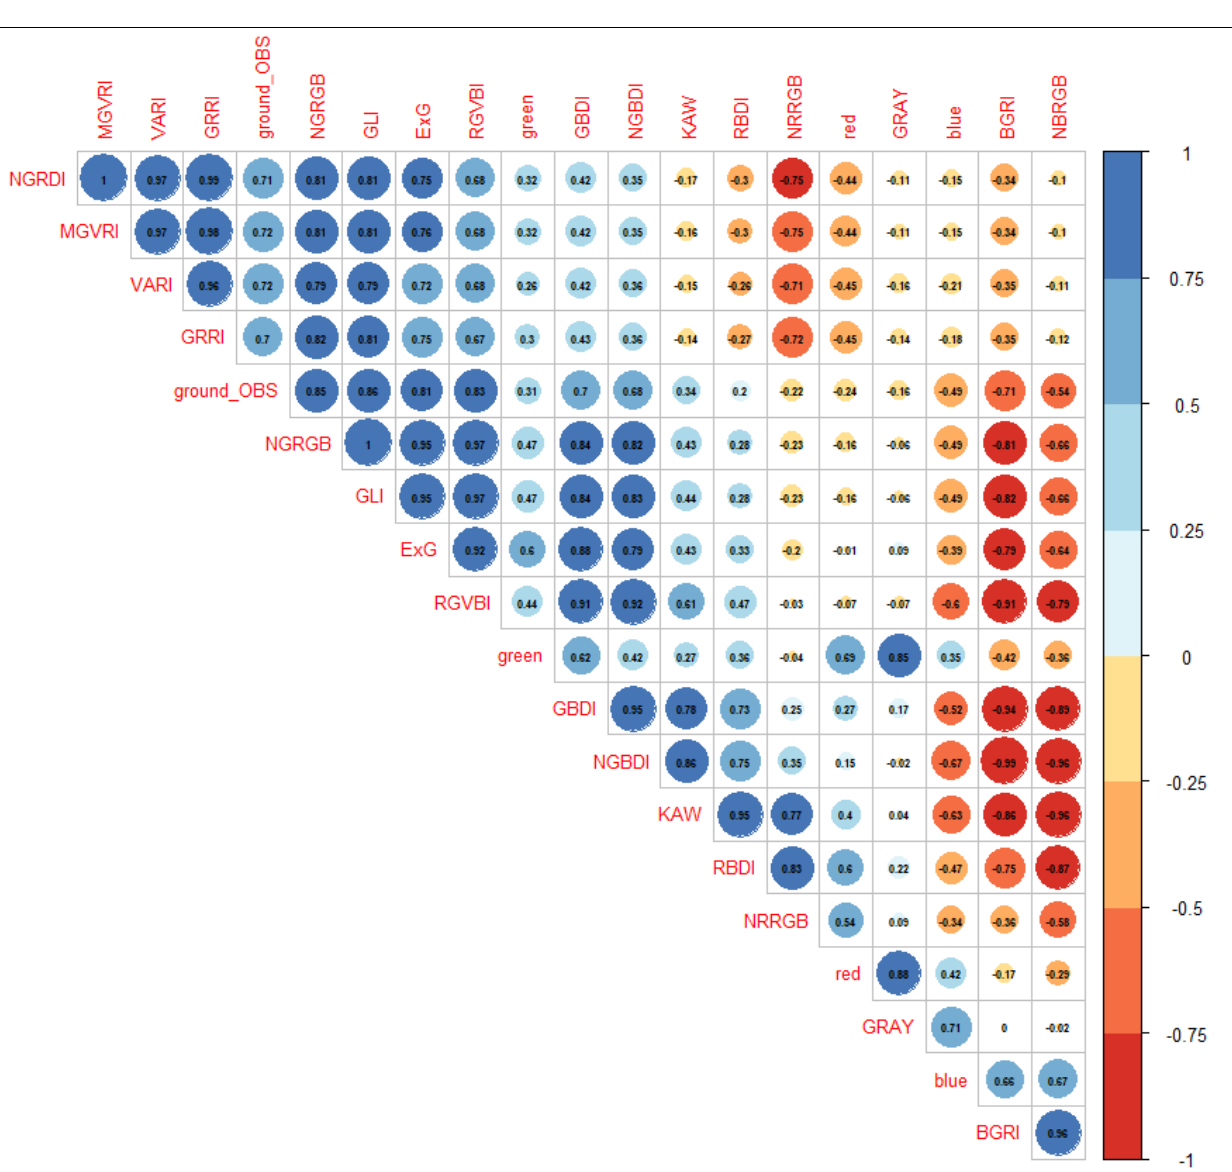
Figure A2. Example of images along the growing season timescale before ( a ) and after ( b ) removing shadows and changing the digital values of pixels to non-value. Dashed magenta regions repre- sented crown delineation and were used to retrieve the RGB band length values.